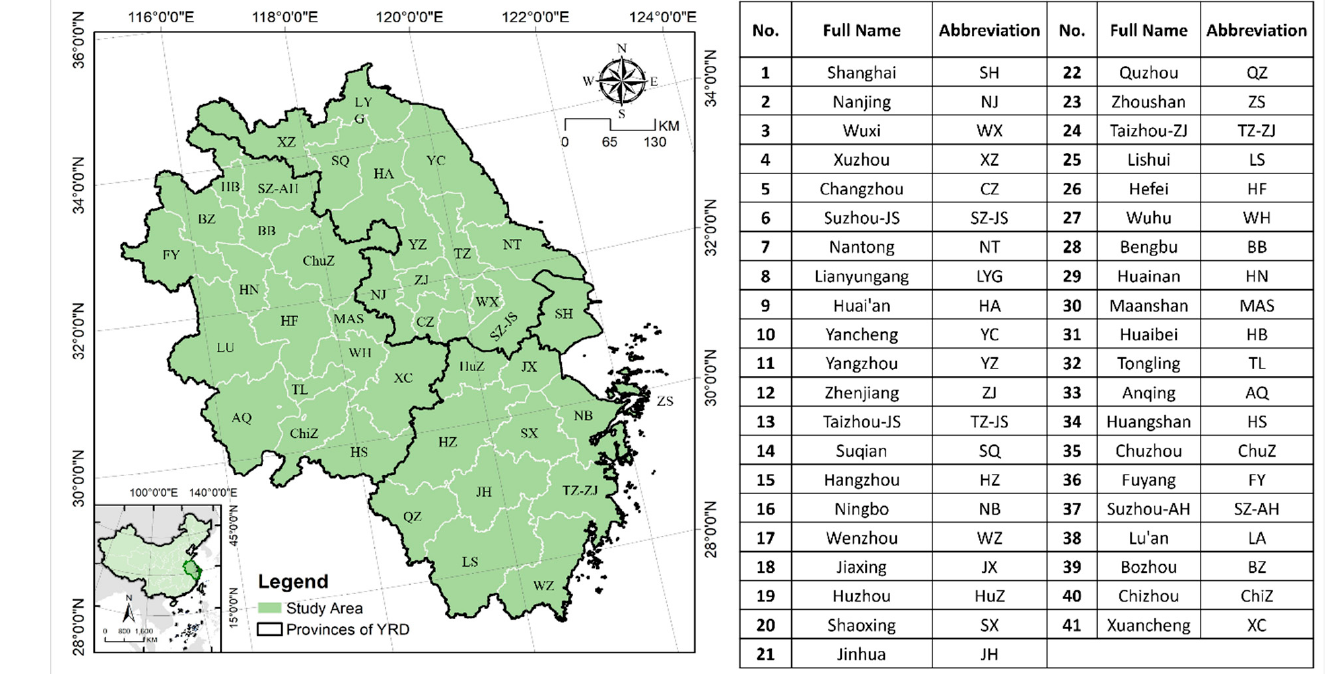
Figure 1. Study area.